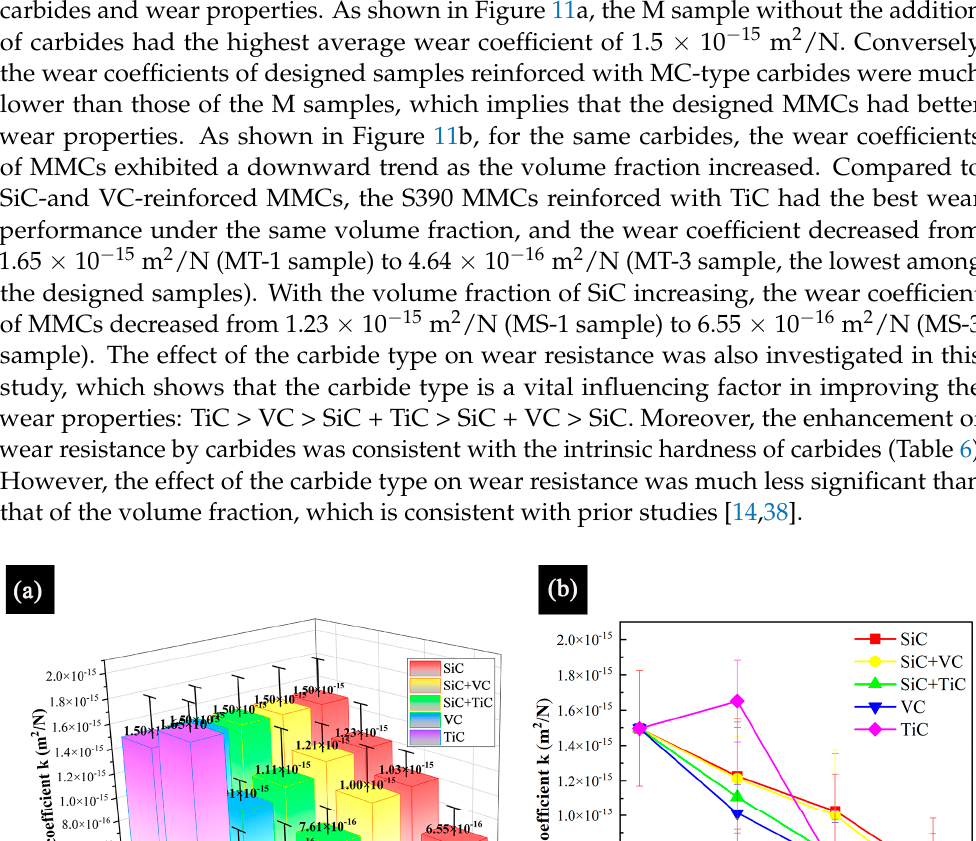
Figure 10. The SEM-BSD and EDS micrographs of the 3-point bending fracture surface of the S390 MMCs: ( a ) MT-3 and ( b ) MV-3.